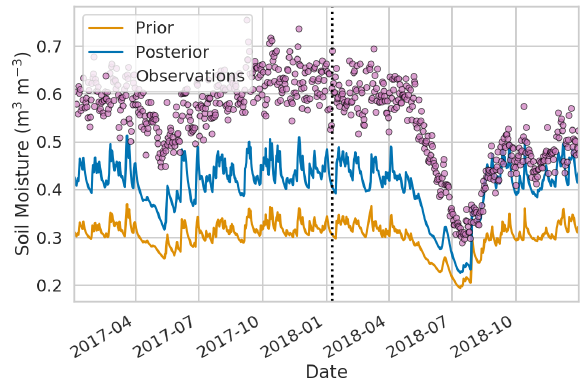
Figure 5. Observed and modelled (ensemble mean) soil moisture time series at Gisburn Forest (GISBN). The dotted line separates the period over which observations have been used for assimilation (2017) from the period in which no observations have been assimi- lated